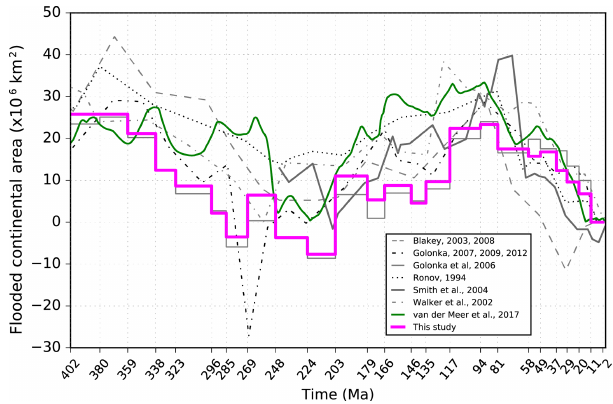
Figure 9. Global flooded continental area since the Early Devonian from the original paleogeographic maps of Golonka et al. (2006; grey solid line) and from the revised paleogeography in this study (pink line). Results for Blakey (2003, 2008), Golonka (2007b, 2009, 2012), Ronov (1994), Smith et al. (2004) and Walker et al. (2002) are as in van der Meer et al. (2017). The van der Meer et al. (2017) curve (green line) is derived from the strontium isotope record of marine carbonates.